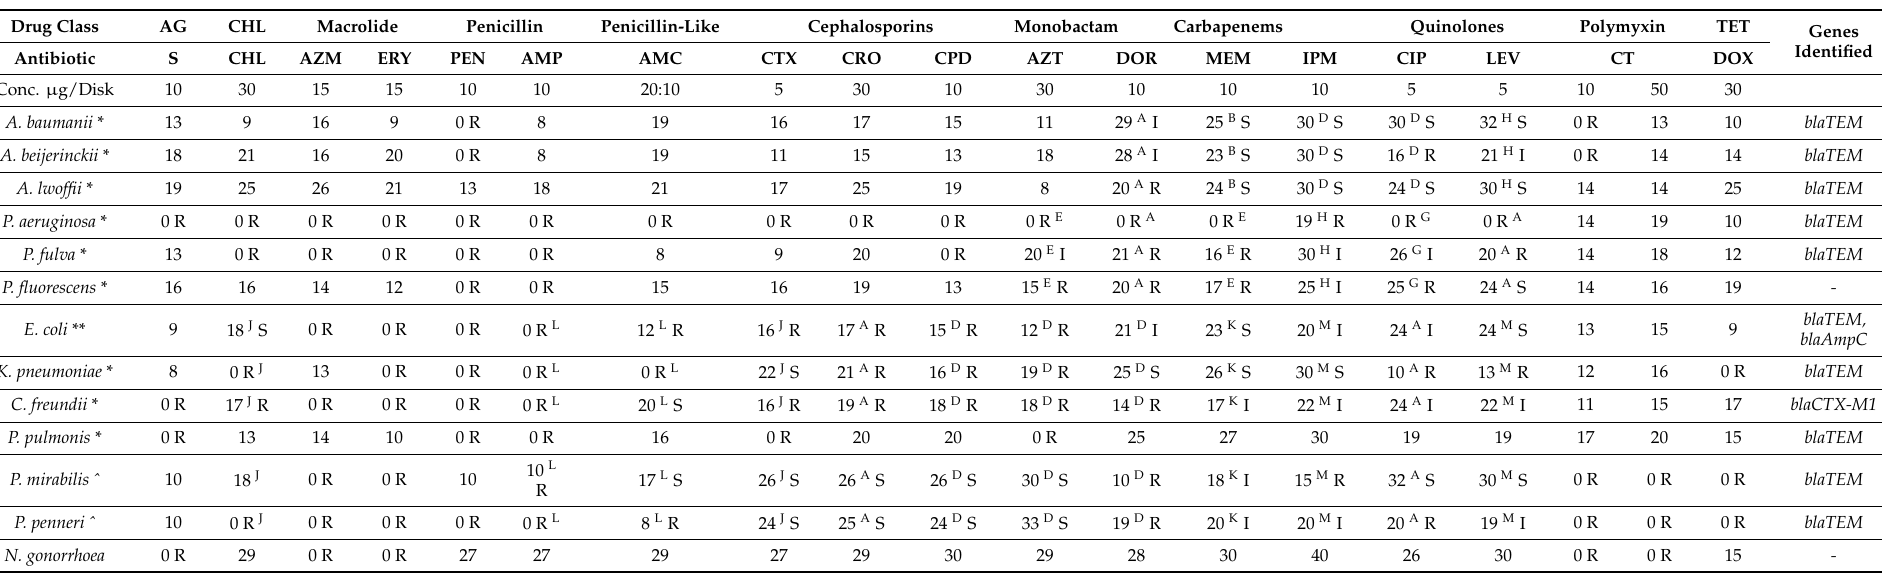
Table 1. Antibiotic profile of test species to a range of antibiotics from varying drug classes with EUCAST target zones given for species for which such information is available. Presence of β -lactamase genes in species is also listed, where ˆ denotes broad-spectrum β -Lactamase producer, * denotes ESBL producer, and ** denotes ESBL and AmpC producer. Drug